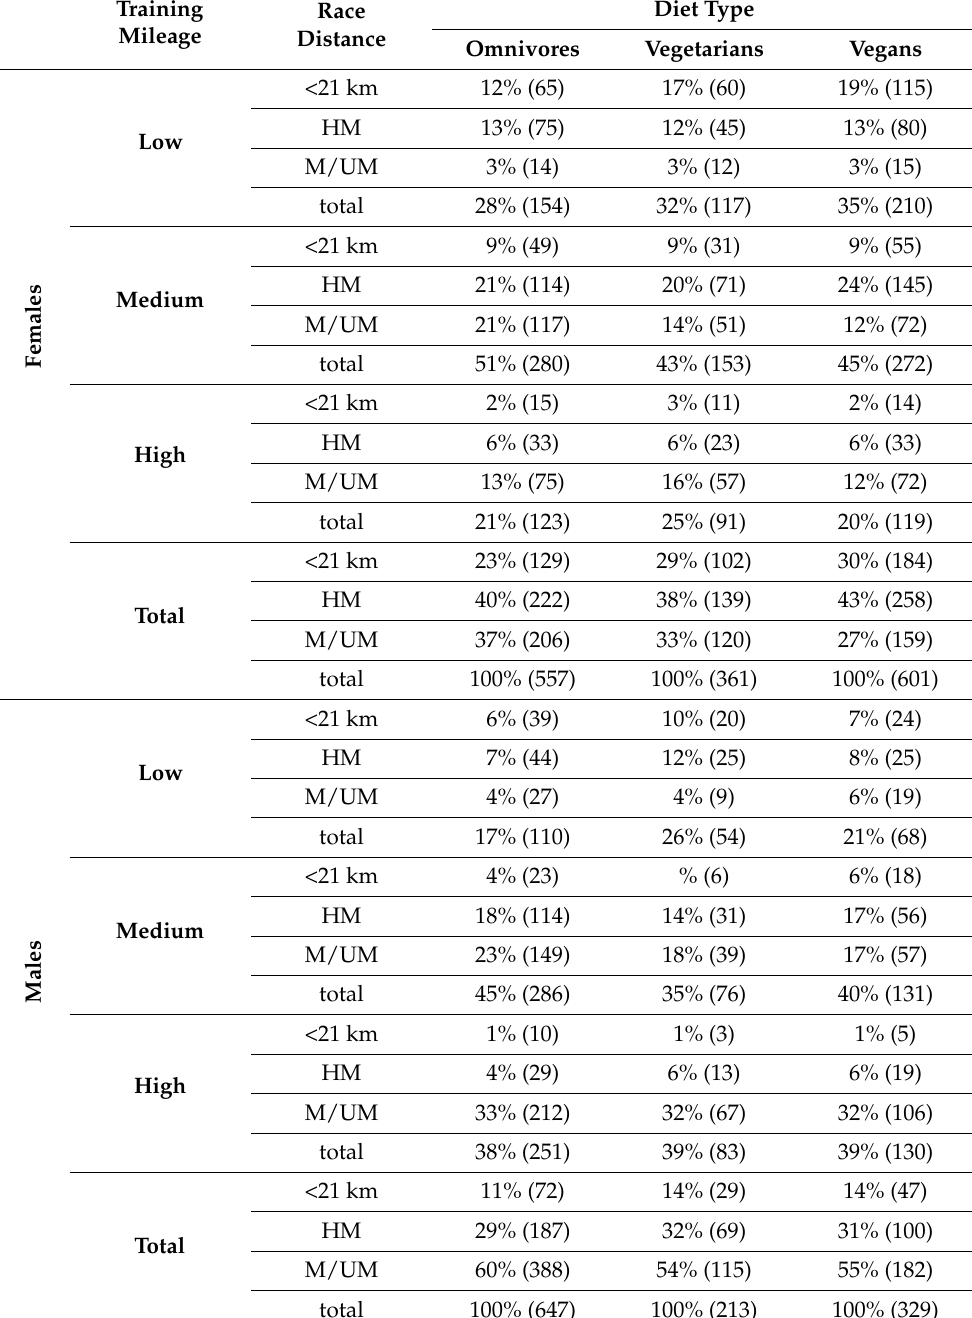
Table 3. Sex-based comparison of dietary subgroups in different training frequencies and race distances. Training Race Diet Mileage